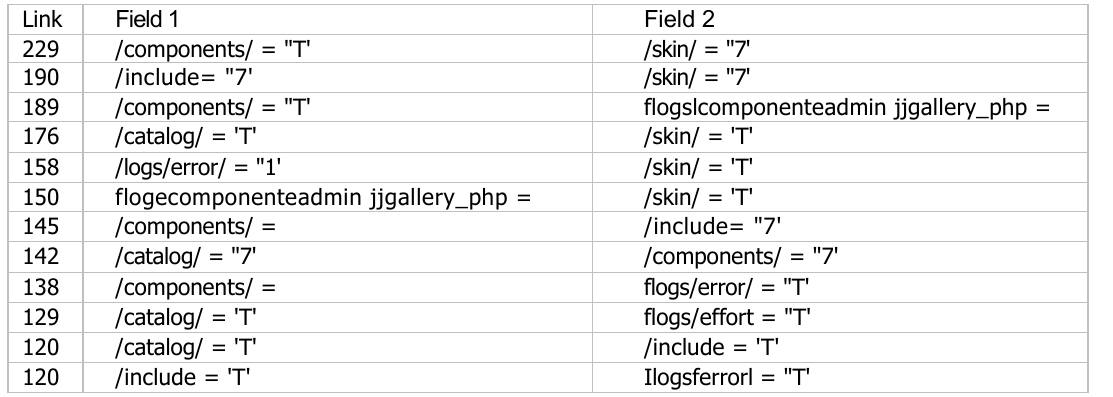
Table 13. Medium links between requests